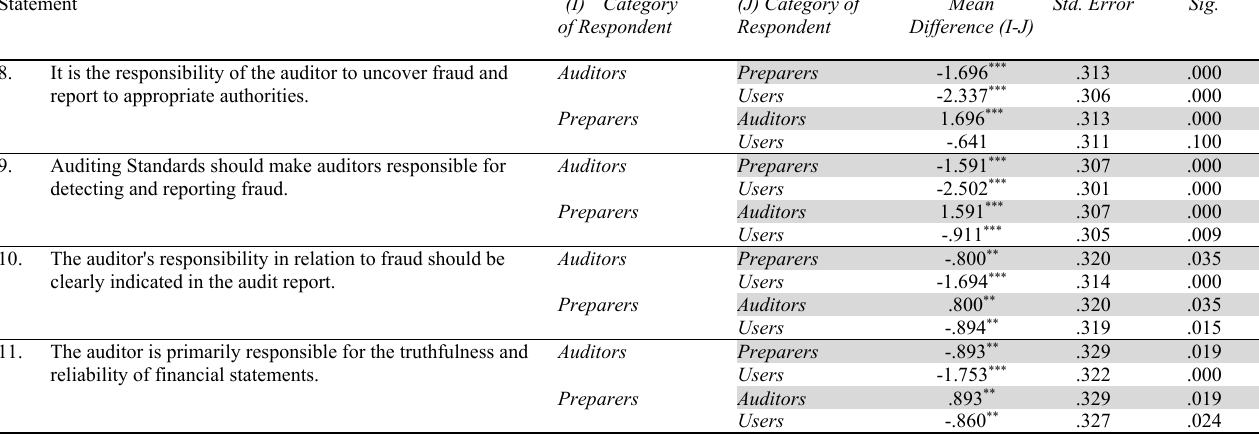
Post Hoc Tests (Multiple Comparisons) - Auditors Responsibility in Relation to